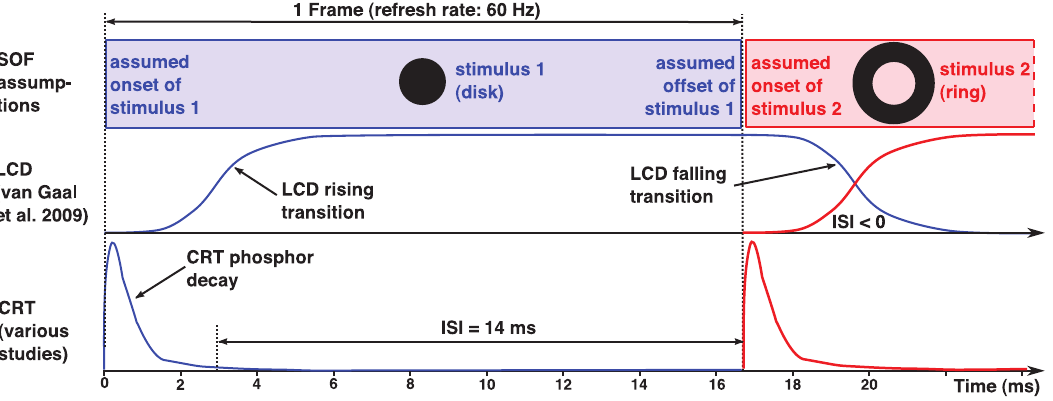
Figure 6. Stimulus succession on CRT vs. LCD monitors. Schematic of the luminance course of a disk stimulus presented for one frame followed by a surrounding ring stimulus. The signals of the disk stimulus are shown in blue, those of the ring stimulus in red. The top row outlines the signal assumptions according to the SOF method. The two underneath rows sketch the true signal shapes on LCD and for CRT monitors, respectively.